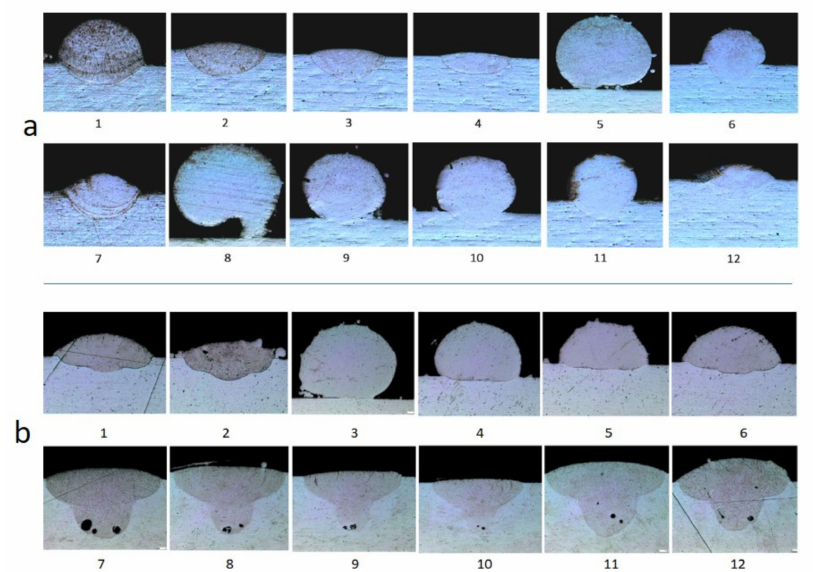
Figure 12. Microstructures of single beads made of steel PR-12H18N9T ( a ) and alloy HN71MTYuB ( b ), obtained by varying the power (80–300 W), scanning speed (100–1700 m/s), and powder feed (1–8